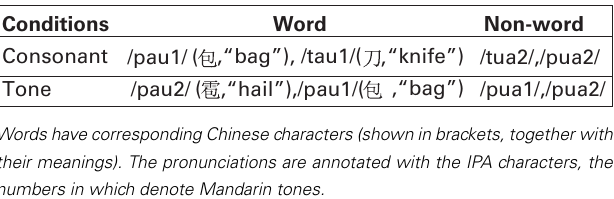
Table 1 | Experimental conditions in Experiment 1, each containing two syllables and four DL